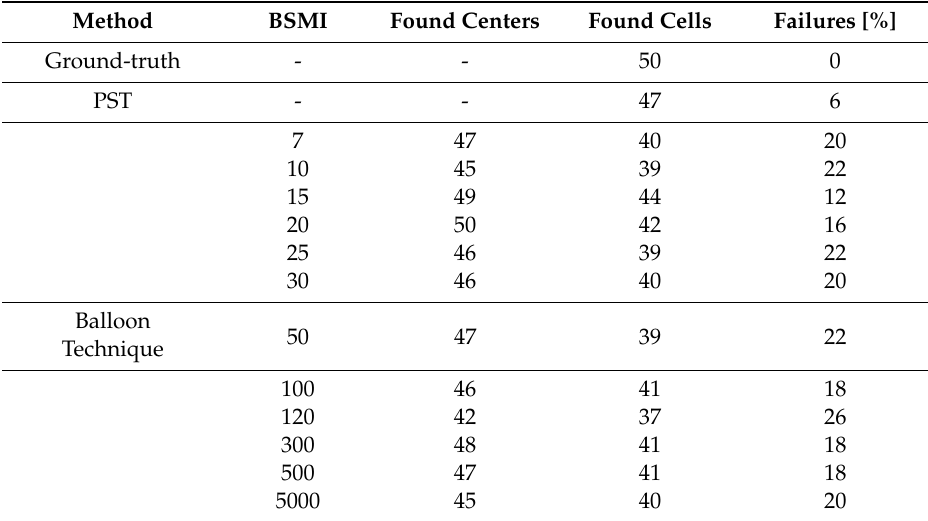
Table 5. Results obtained with the proposed method and the BSMI technique.